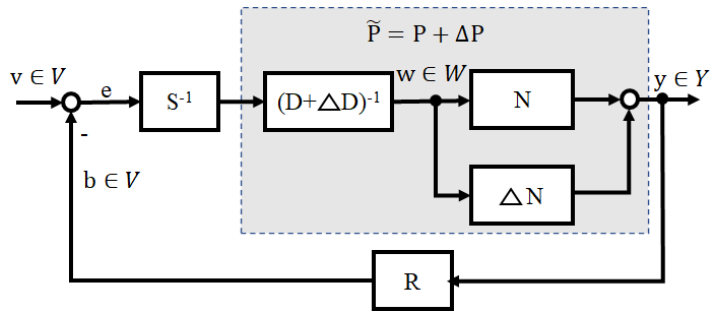
Figure 4. Nonlinear operator-based feedback control system with